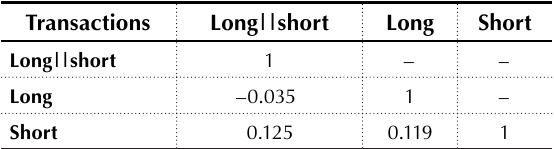
Table 7. Table of correlation coefficients between backtesting periods of the three PIVOT systems on COTTON